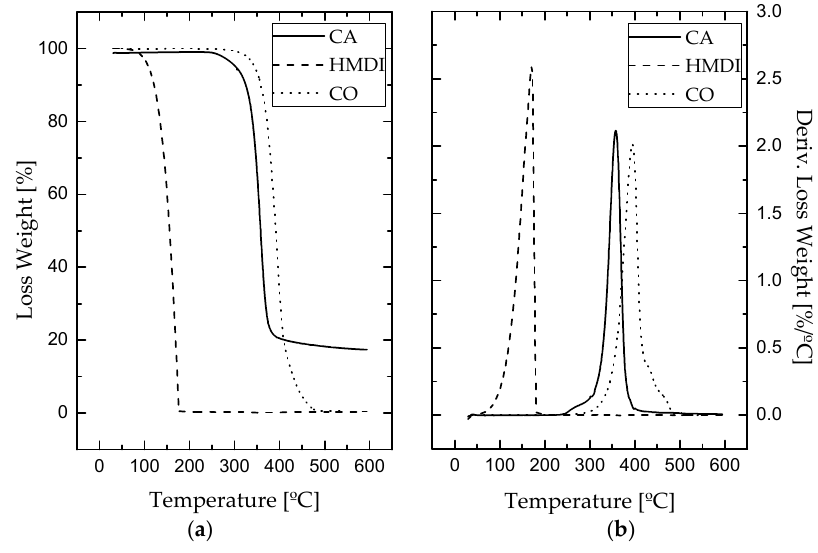
Figure 3. ( a ) Loss weight and ( b ) derivative loss weight curves for cellulose acetate, 1,6-hexamethylene diisocyanate (HMDI) and CO raw materials. Table 1. Thermal parameters obtained from thermogravimetric analysis curves.